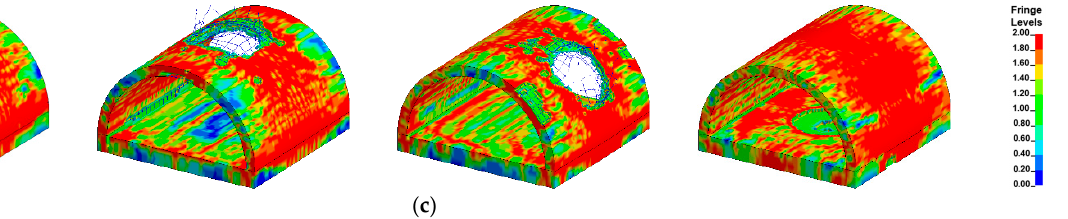
Figure 13 . Damage pattern of the prototype of tunnel entrance with different TNT masses: ( a ) W = 200 kg; ( b ) W = 600 kg; ( c ) W = 1000 kg; (From left to right the detonation points are: center, crown, hance and foundation slab).